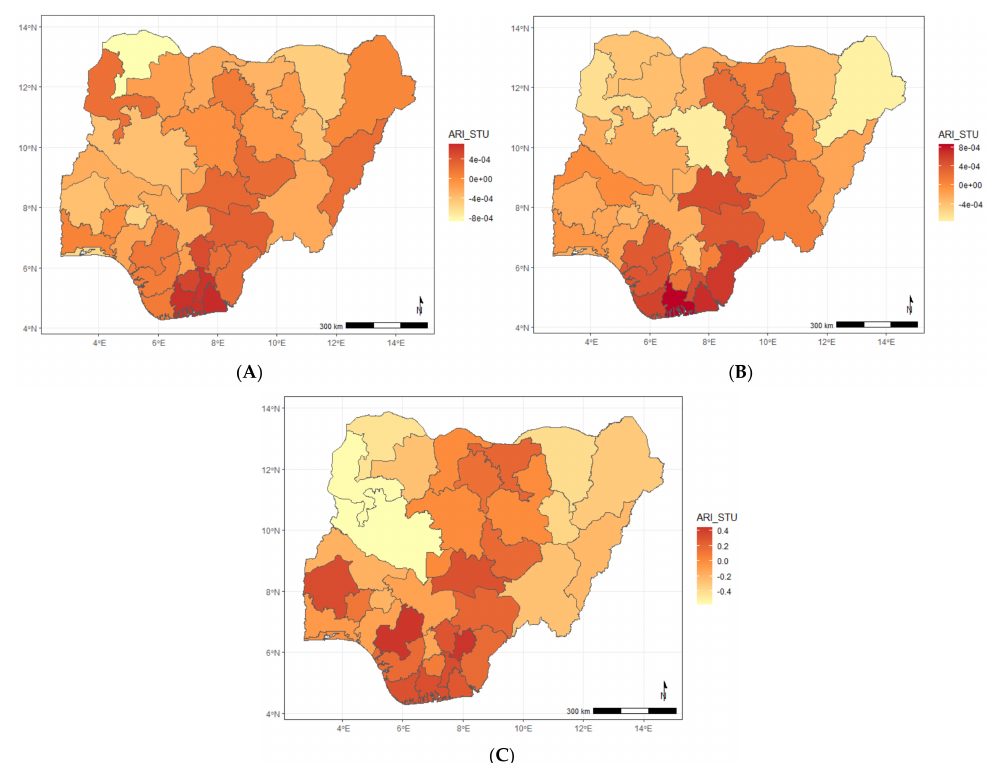
Figure A5. Maps showing posterior estimates of the ARI and stunting spatial shared effect by year of NDHS implementation; ( A ) 2008, ( B ) 2013, ( C ) 2018.